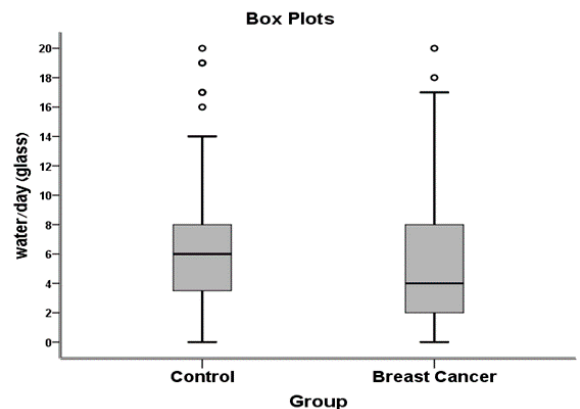
Figure 1. Water consumption (glasses/day).